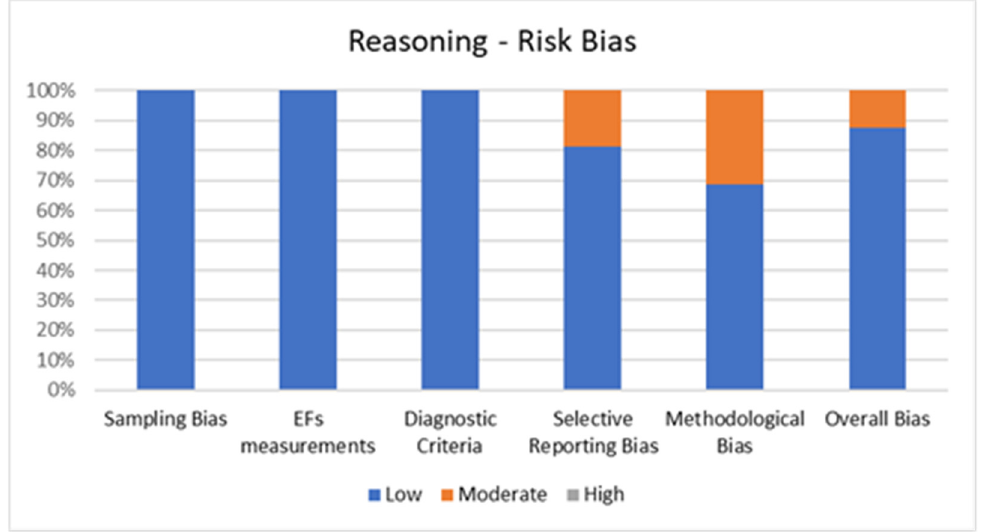
Figure 4. Risk of Bias for Reasoning.